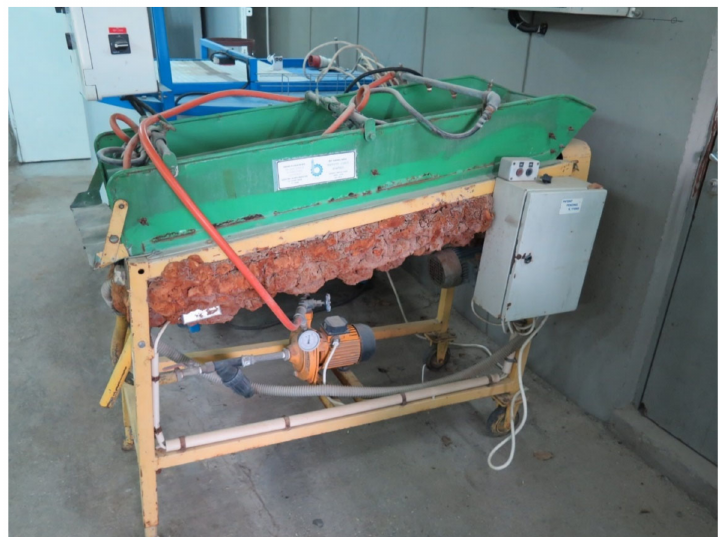
Figure 1. First version—prototype, 1996 (photo by E.